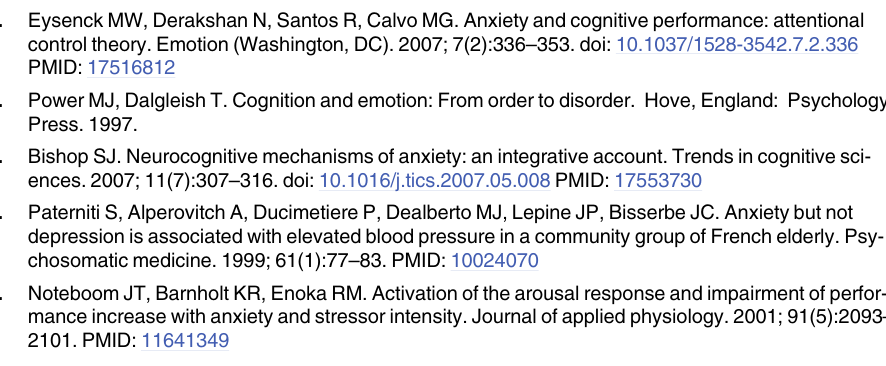
S1 Table. Formulae to adjust nonlinear HRV indexes for mean RR (avRR). S2 Table. Heart rate variability and anxiety